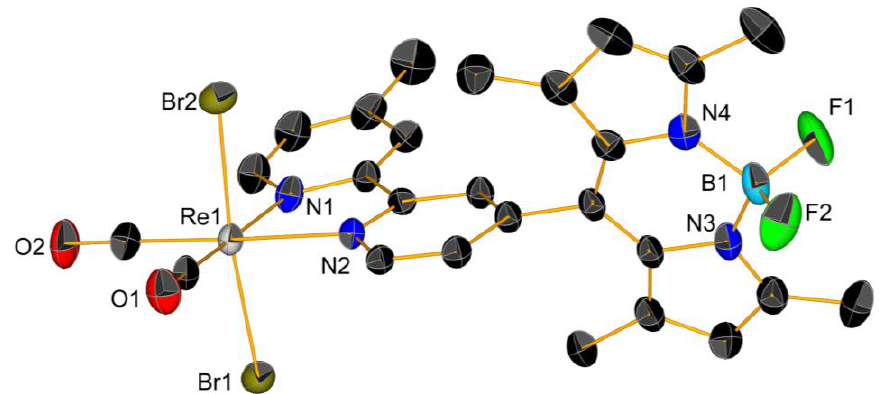
Figure 1. The ORTEP representation of crystal structure of the [Re(CO) 2 -BODIPY] derivative. Thermal ellipsoids are at 30% probability. Hydrogen atoms are omitted for clarity.